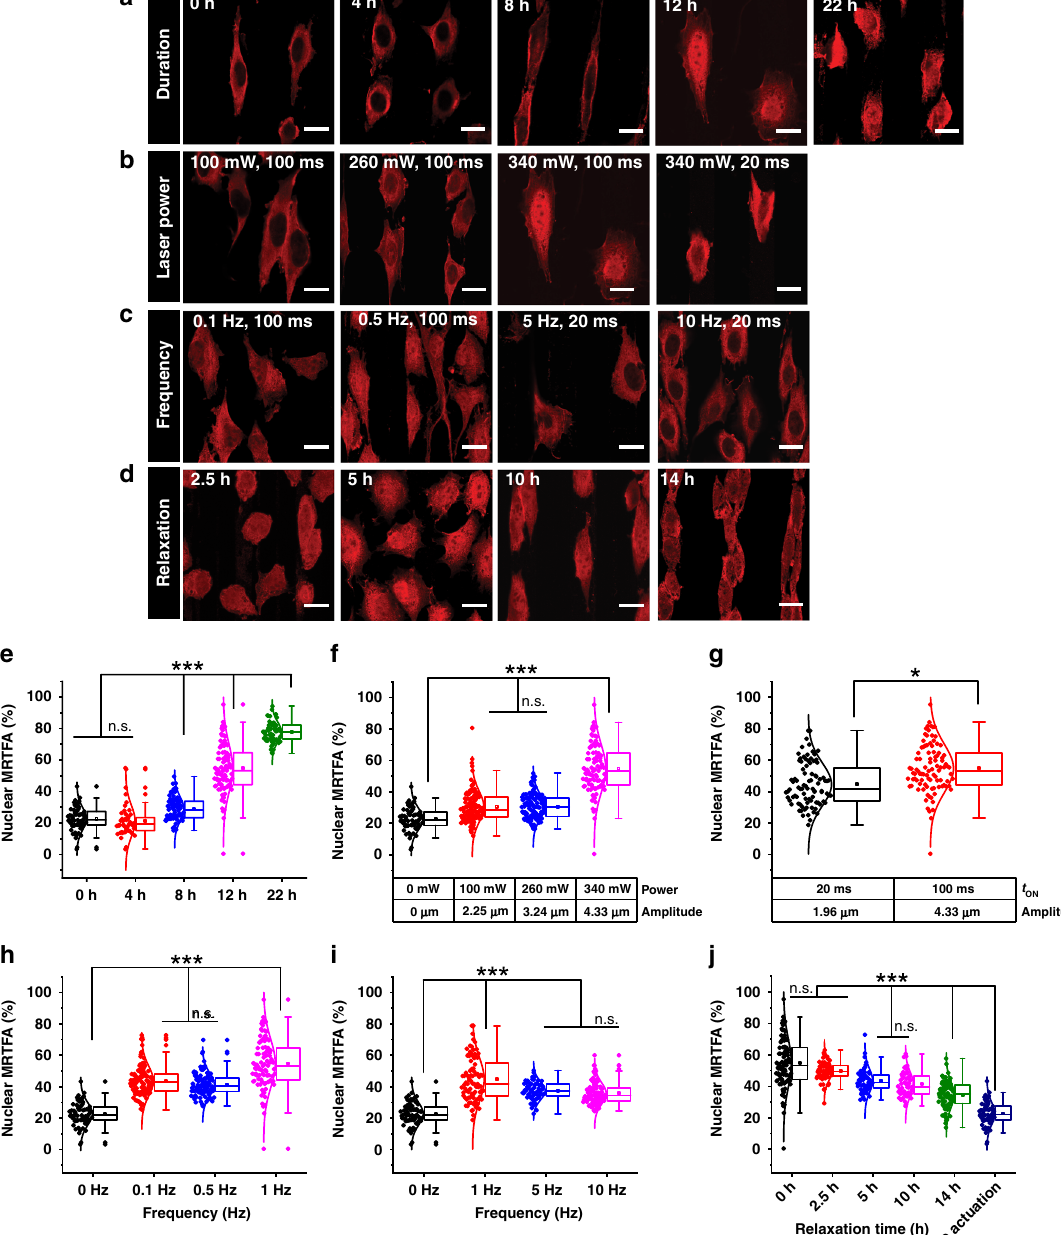
Fig. 4 Immuno fl uorescence images showing the distribution of MRTFA in the cells. a Cells are actuated for 0, 4, 8, 12 and 22 h (340 mW, 1 Hz, 100 ms laser ON time), b The actuation amplitude is varied by using a laser power of 100 mW, 260 mW or 340 mW (1 Hz, 100 ms ON time, 12 h actuation), or by reducing the laser pulse to 20 ms at 340 mW laser power and 1 Hz frequency. c Cells are actuated at 0.1 Hz and 0.5 Hz at 340 mW (100 ms ON time,12 h actuation), while higher frequencies of 5 Hz and 10 Hz are obtained using a shorter ON time of 20 ms, keeping the laser power constant (340 mW). d After actuating for 12 h (340 mW, 1 Hz, 100 ms laser ON time), actuation is ceased and cells are allowed to relax for 2.5, 5, 10 and 14 h. e – j The nuclear MRTFA % is measured to assess the effect of e duration of actuation, f actuation amplitude by changing laser output, g actuation amplitude by changing the ON time of the laser pulse, h frequency when ON time = 100 ms, i frequency when ON time = 20 ms and j relaxation. Scale bar = 20 µ m. The box plots show the nuclear MRTFA % for each cell ( n ≥ 3, N ≥ 60 cells, except e , where N ≥ 48 cells). In the box plots, the interquartile range (IQR) between the fi rst and the third quartiles is indicated by the box, while whiskers denote 1.5 IQR. The hollow square, the horizontal line, and the fi lled dots represent the average, the median, and the outliers, respectively. On the left of the box plot, all data points are shown, the normal distribution curve serves to guide the eye. *, **, *** are determined using one way ANOVA or Welch test, depending on the homogeneity of variances, and represent statistical signi fi cance at p < 0.05, 0.01 and 0.001,